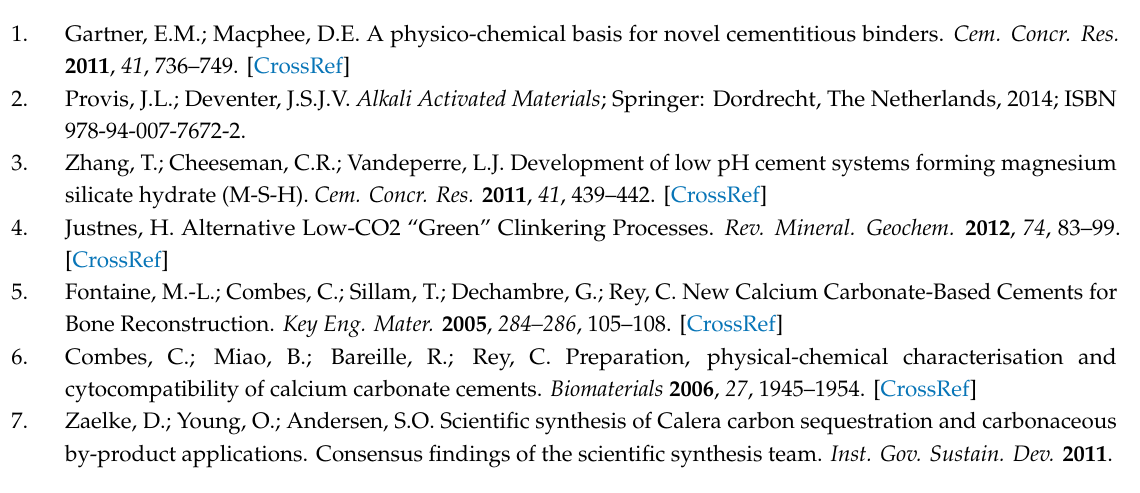
Supplementary text and Figure S1: Local slopes of calcite mass fractions, Figure S2: Normalized mass